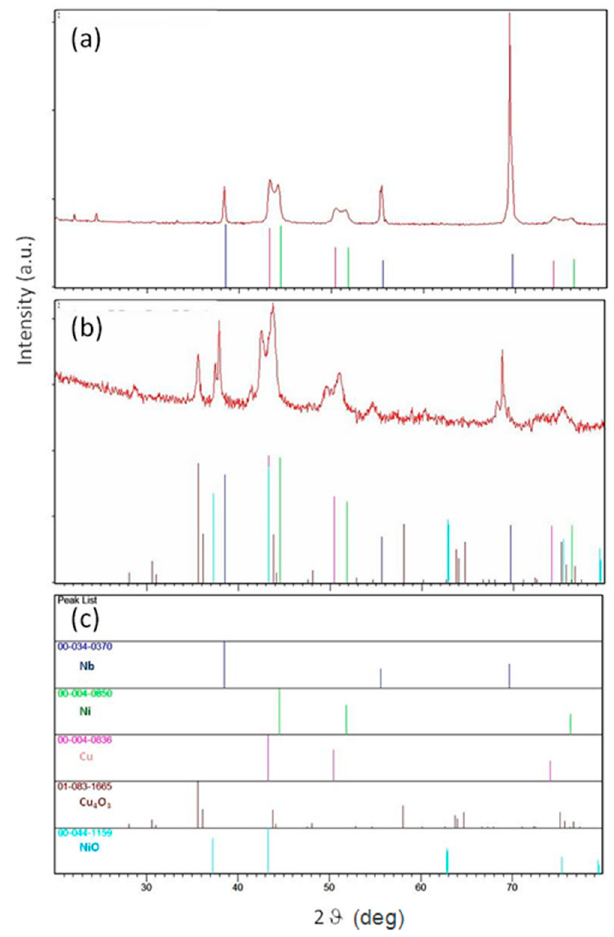
Figure 3. XRD pattern of the films as-deposited ( a ) and of the sample S 1–5 after the corrosion ( b ) and relevant PDF cards for reference structures.